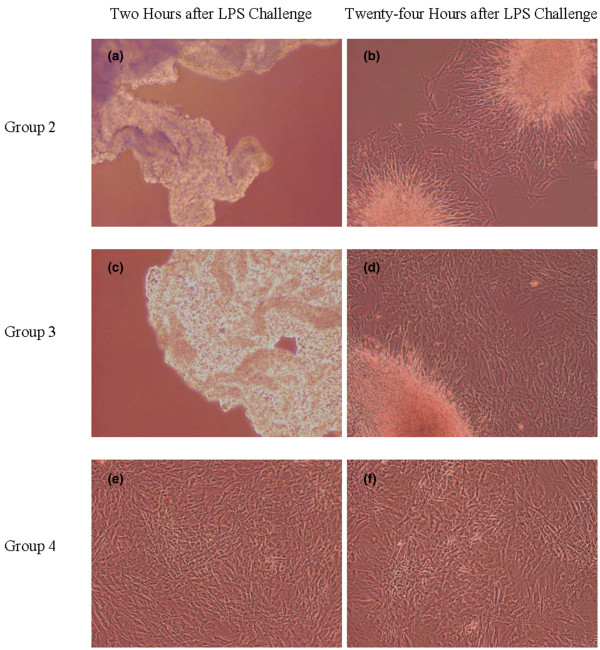
Representative microscopic images of fibroblast-like synovial cells post-lipopolysaccharide challenge. Representative microscopic images (400× magnification) of fibroblast-like synovial cells (a), (c), and (e) 2 hours post-lipopolysaccharide (LPS) challenge and (b), (d), and (f) 24 hours post-LPS challenge. Cells treated with the higher molecular weight hyaluronan (HA) product (group 4, pretreatment and sustained treatment with higher molecular weight HA) were protected from (d) and (e) the morphologic changes induced by LPS, including the loss of cell attachment to the culture flask and the pronounced cellular contraction that were seen in (a), (b) group 2 (LPS control) and (c), (d) group 3 (preteatment and sustained treatment with lower molecular weight HA).